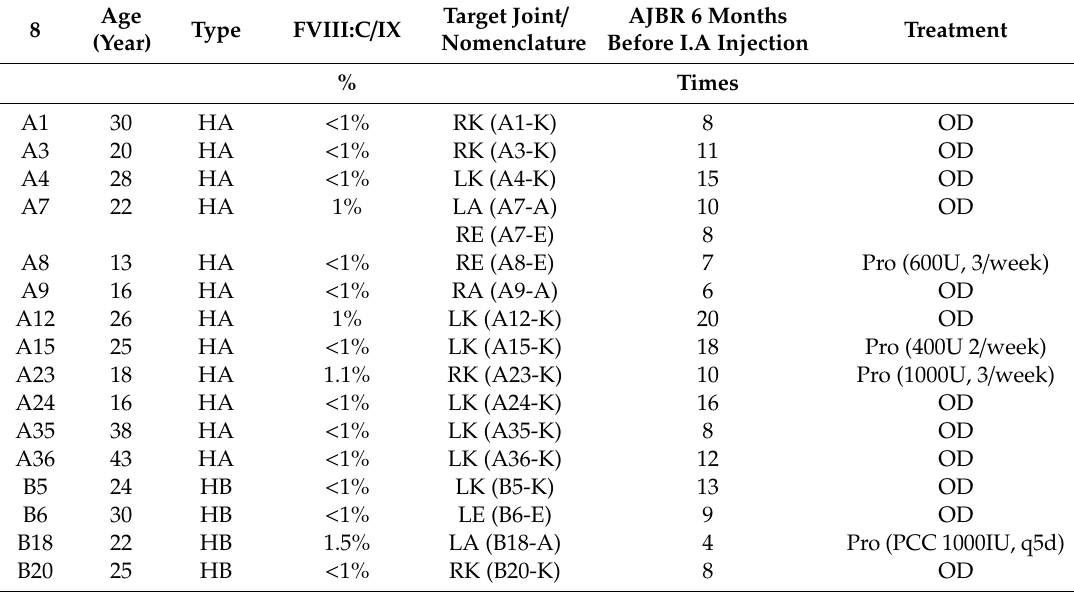
Table 1. Demographic data of